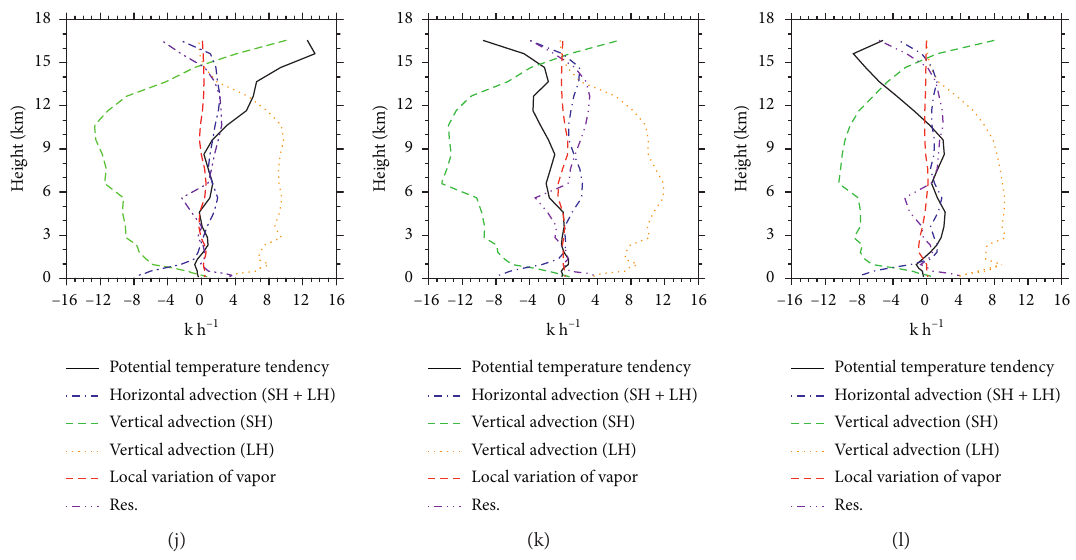
Figure 12: Terms from the diagnosis equation of virtual potential temperature (equation (2)) averaged over a radius of 80km (unit: k h − 1 ). The black line indicates the tendency of virtual potential temperature ( z θ v / z t ) multiplied by 5 for a clearer display. The green line indicates sensible heat (SH) from vertical advection ( − w · z θ v / z z ). The blue line indicates latent heat (LH) from horizontal advection ( − ( u · z θ v / r z φ +( θ v L v,s,f )/( C pd T v ) · u z q / r z φ − v · z θ v / z r +( θ v L v,s,f )/( C pd T v ) · v z q / z r )). The orange line indicates LH from vertical advection ( − ( θ v L v,s,f )/( C pd T v ) · w z q / z z ). The red line indicates LH from water vapor tendency ( − ( θ v L v,s,f )/( C pd T v ) · z q / z t )). The purple line indicates the residual term. (a) Stage 1, cycle 1. (b) Stage 2, cycle 1. (c) Stage 3, cycle 1. (d) Stage 1, cycle 2. (e) Stage 2, cycle 2. (f) Stage 3, cycle 2. (g) Stage 1, cycle 3. (h) Stage 2, cycle 3. (i) Stage 3, cycle 3. (j) Stage 1, cycle 4. (k) Stage 2, cycle 4. (l) Stage 3, cycle 4.